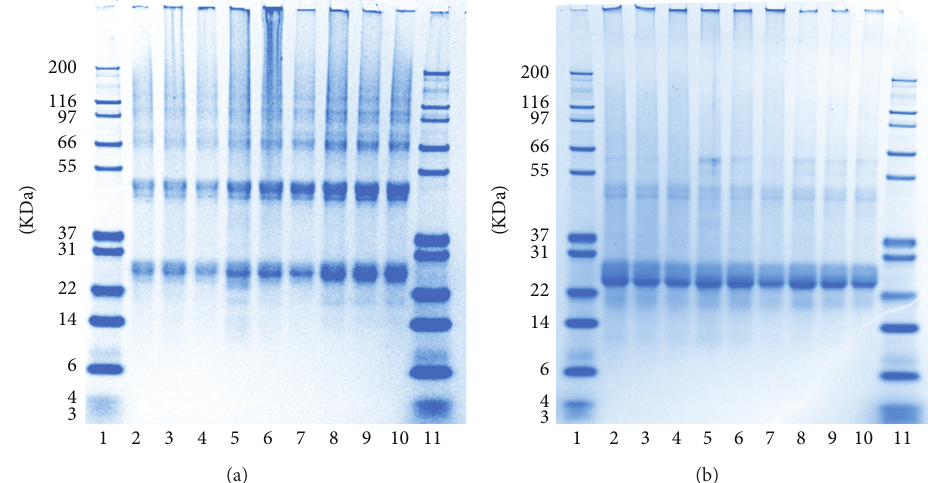
Figure 3: (a) Sodium dodecyl sulphate-polyacrylamide gel electrophoresis under nonreducing conditions and (b) under reducing conditions of kafirin from raw white sorghum grain (lane 2); empty kafirin microparticles from raw white sorghum (lane 3); drug-loaded microparticles from raw white sorghum (lane 4); kafirin from raw red sorghum (lane 5); empty kafirin microparticles from raw red sorghum (lane 6); drug- loaded microparticles from raw red sorghum (lane 7); kafirin from cooked red sorghum (lane 8); empty kafirin microparticles from cooked red sorghum (lane 9); and drug-loaded microparticles from cooked red sorghum (lane 10). Molecular weight markers are seen in lanes 1 and